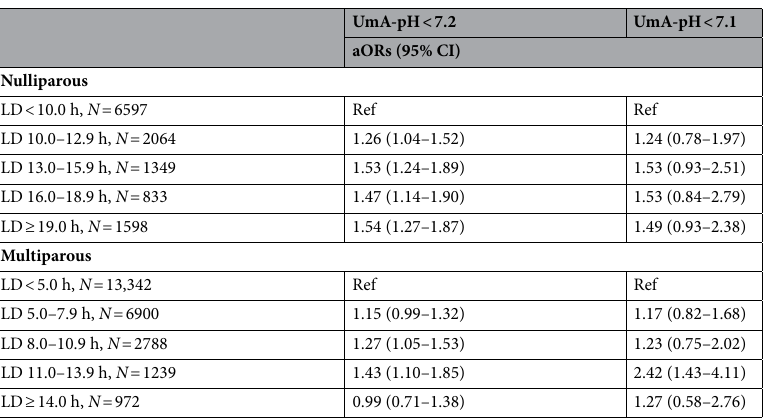
Table 3. Adjusted odds ratios for foetal acidosis in nulliparous and multiparous women with each labour duration category in over-median labour duration. Maternal age, pre-pregnancy body mass index, gestational weight gain, maternal smoking status, maternal alcohol consumption status, maternal educational status, annual household income, neonatal birth weight, and presence of hypertensive disorders of pregnancy were used as confounding factors. aORs, adjusted odds ratios; CI, confidence interval; LD, labour duration; Ref, reference; UmA, umbilical